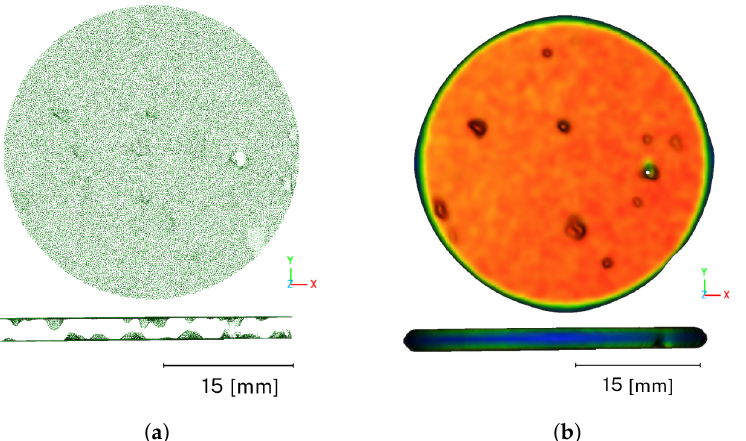
Figure 7. The point cloud ( a ) and the 3D mesh model created by Poisson surface reconstruction ( b ) of slice no.